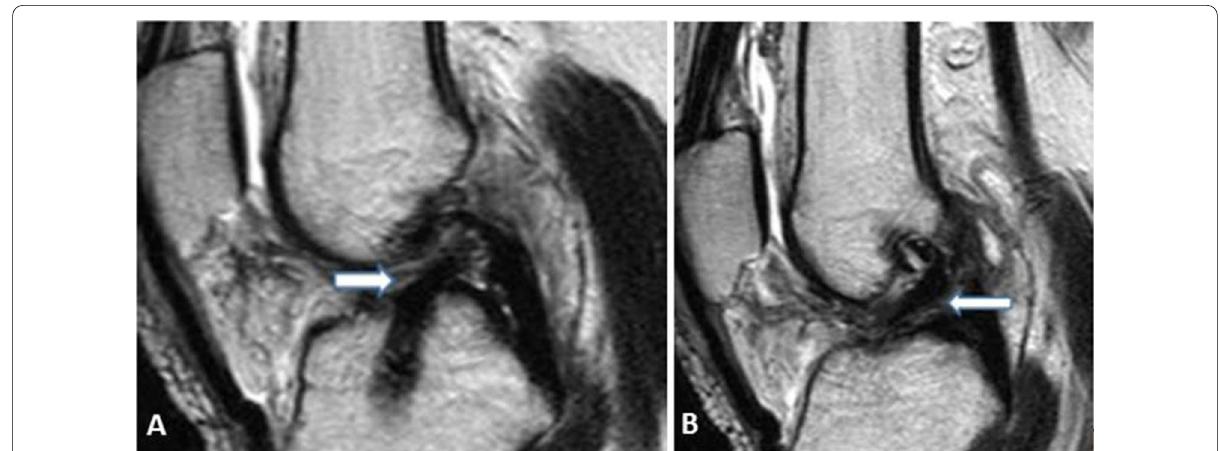
Fig. 7 36-year-old male patient with history of right ACL reconstruction. He came now with right knee pain increasing with movement and knee instability. A and B sagittal T2WI (protocol A) showing lax orientation of the ACL graft fibers with fuzzy outline, suggesting grade 1 graft injury (thick white arrows)